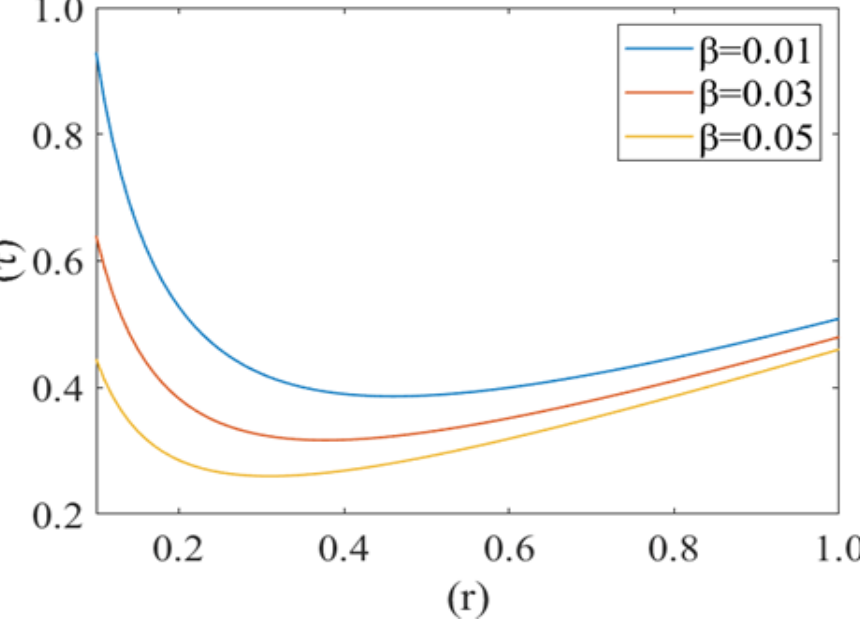
Figure 10. Drag force ( τ ) at the rim of the deformed cell with respect to its deformed radius ( r ) at different cell compliances ( β ) with Re = 0.25, P1 = 2, k = 0.1.